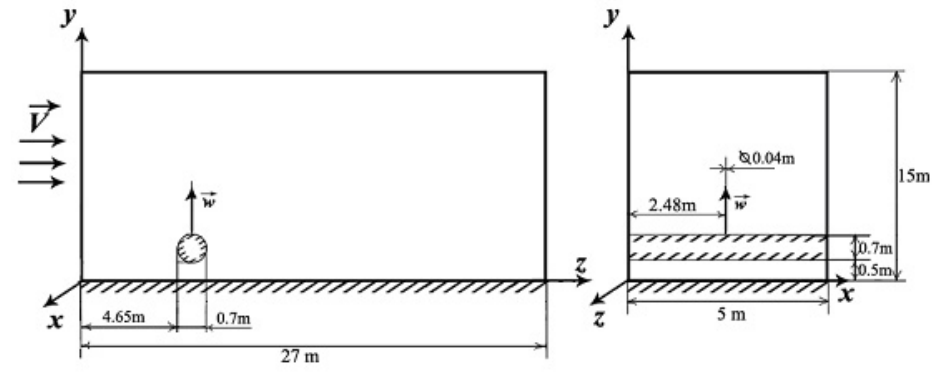
Fig. 2. Schematic representation of the problem and coordinates: longitudinal view (along the ambient current); transversal view (along the diffuser).